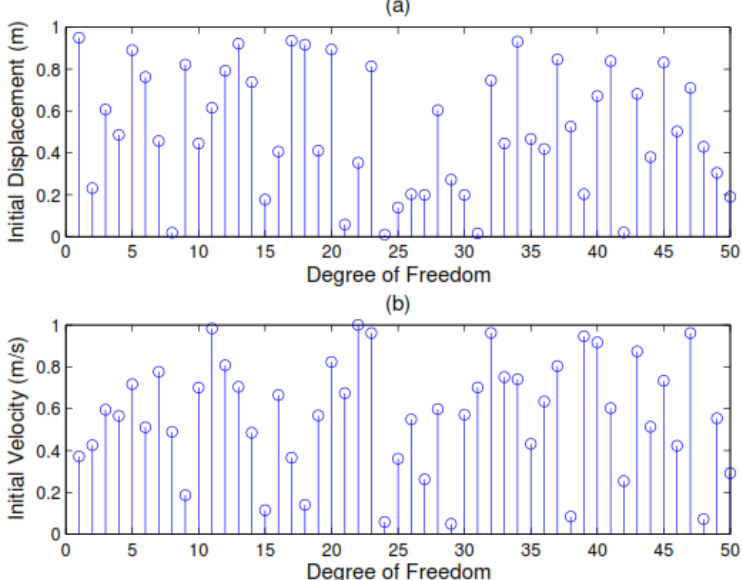
Figure 12. The randomly generated initial conditions: ( a ) initial displacement and ( b ) initial velocity.